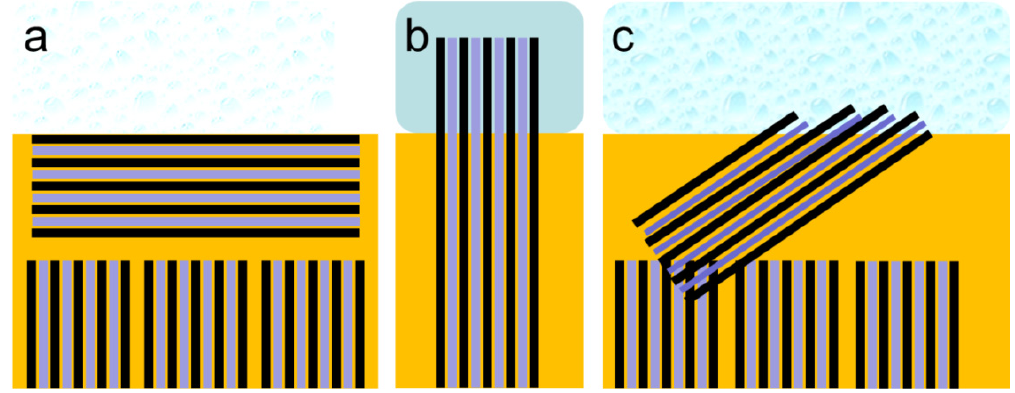
Figure 1. ( a ) Drawing of the equilibrium structure of the Nafion ® –water vapor interface with bundles of Nafion ® fibrils parallel to the interface forming an interface layer several nanometers thick without connection to water vapor at the surface according to Bass et al. [6]. ( b ) Drawing of the equilibrium structure of the Nafion ® –water interface with bundles of Nafion ® fibrils vertical to the interface with connection to the water phase according to Bass et al. [6]. ( c ) Scheme of the non-equilibrium structure of Nafion ® measured under current at the water/vapor